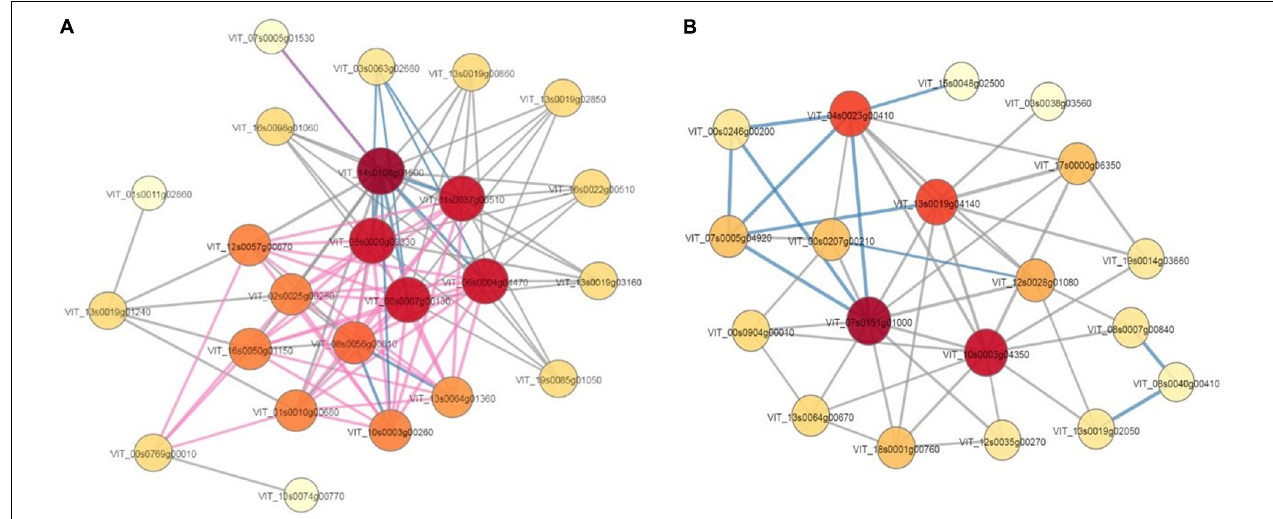
FIGURE 9 | Protein-protein interaction network of differentially expressed proteins. (A) Proteins involved in heat shock. (B) Proteins involved in photosystems.